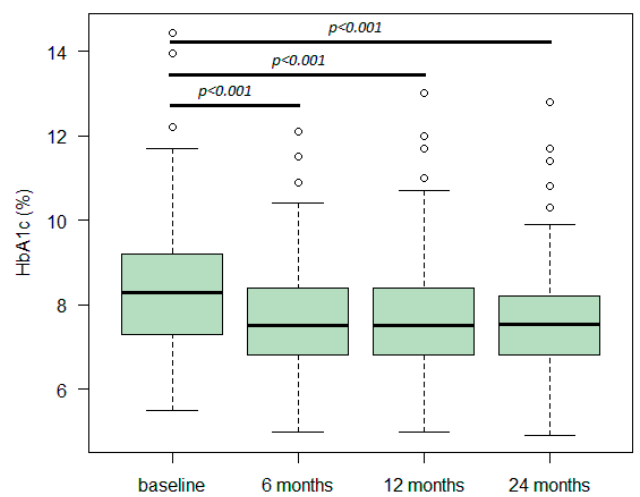
Figure 1. HbA1c (%) variation over time. HbA1c variation from baseline to 24 months. Boxes indicate the median and the P25/P75 percentiles, whiskers indicate the range of values, and dots correspond to outliers. Statistical analysis was performed using a linear generalised mixed-effects model with an associated identity function.